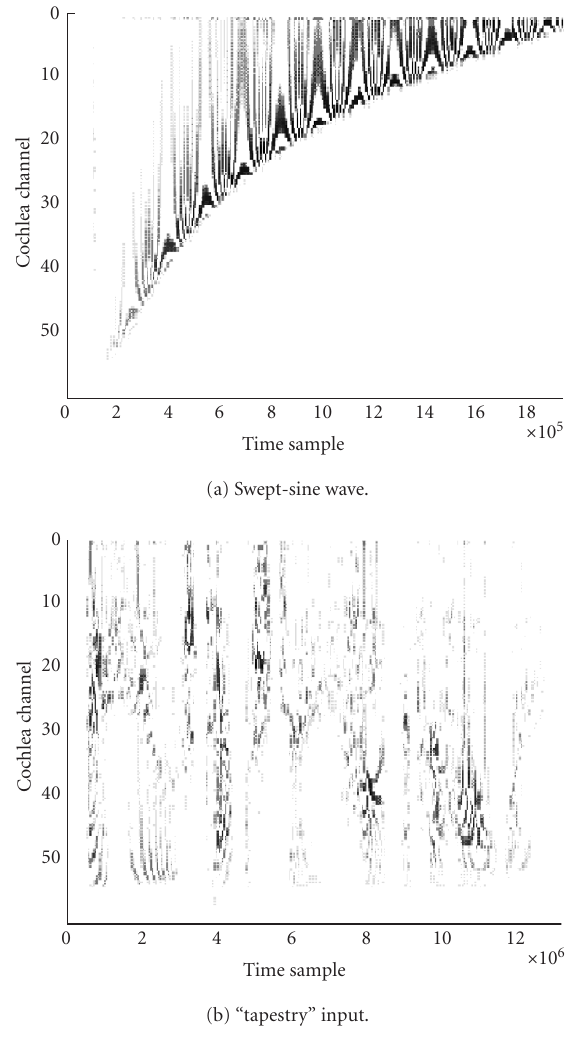
Figure 9: Cochleagrams of (a) swept-sine wave and (b) “tapestry” inputs. The former has 400000 samples while the latter has 50380 samples. Only the first 60 out of the 88 cochlea sections were used because of limited hardware resources on a Xilinx XCV1000-6 FPGA. These cochlea sections correspond to a frequency range of 1006–7630